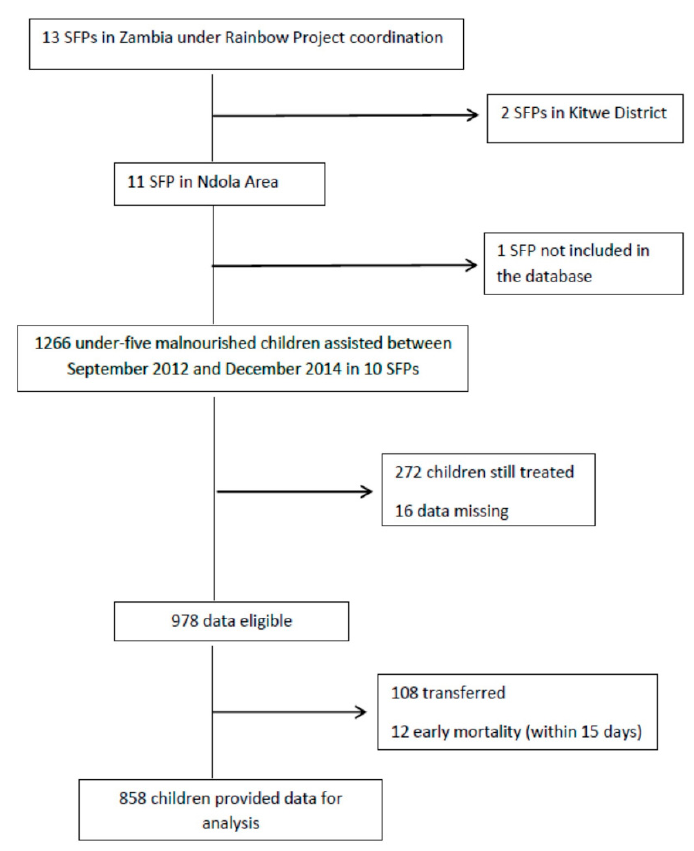
Figure 1. Study Figure 1. Study flowchart.